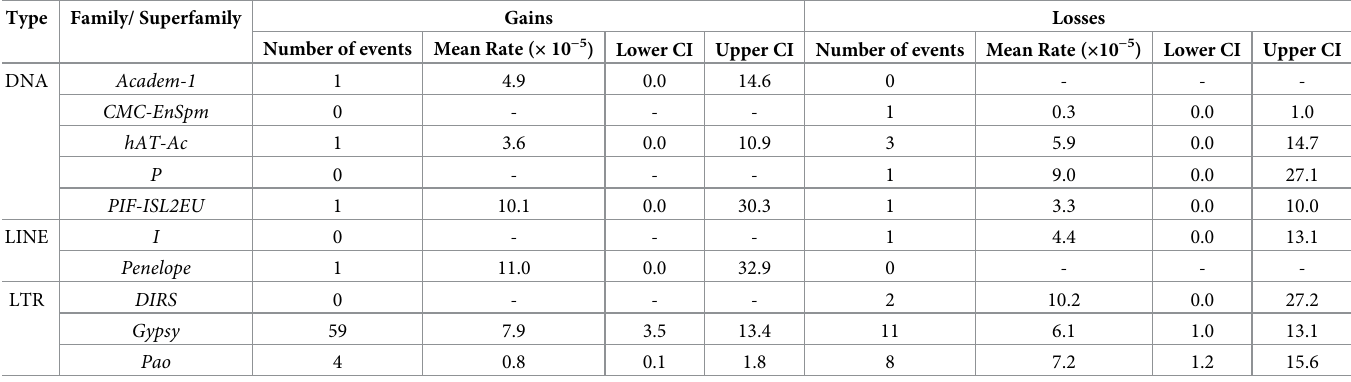
Table 3. Number of events and rates (plus 95% confidence intervals [CI]) of gain and loss (per copy per generation) for each TE superfamily in which events were observed averaged across all MA lines. Gains and losses based on whole genome sequence data from Daphnia magna mutation accumulation lines descended from 9 starting genotypes collected from Finland, Germany, and Israel.